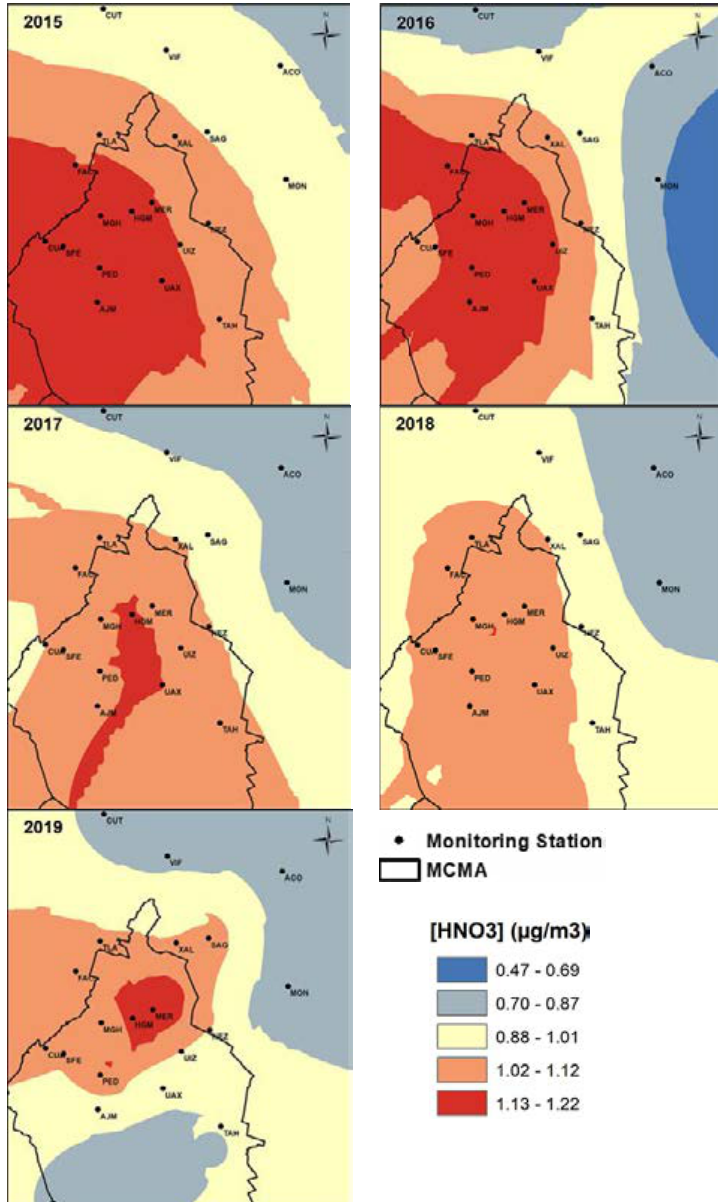
Fig. 3: Maps of concentration layers of the annual average of [HNO 3 ] (µg/m 3 ) for the period 2015-2019 in the